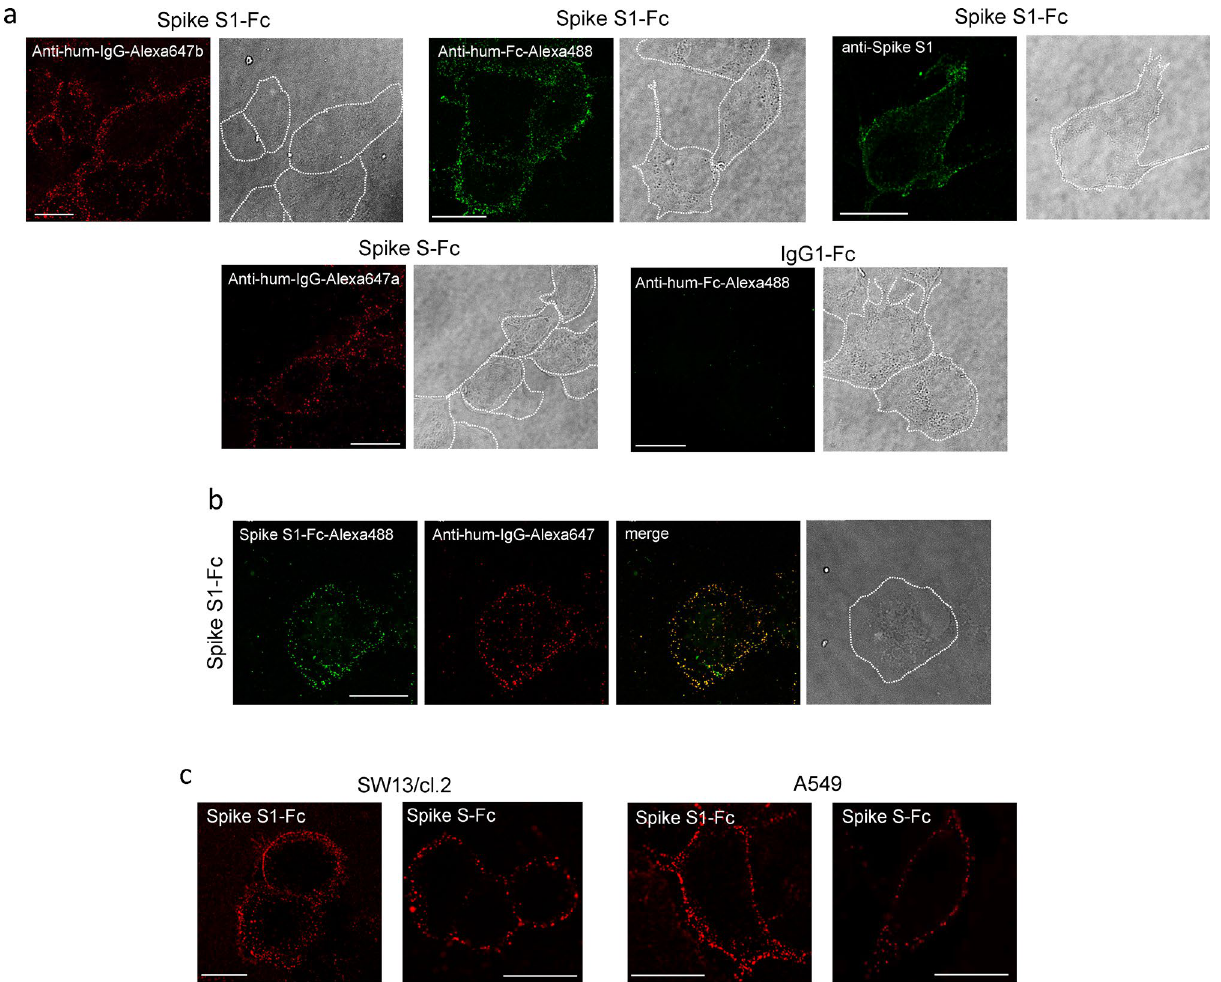
Figure 1. Detection of Spike protein constructs at the cell surface. ( a ) Vero cells plated on glass coverslips were incubated with recombinant Spike S1-Fc, Spike S-Fc, or IgG1-Fc, as indicated, for 1 h in the cold, as described in “Methods”, and the proteins retained on the cell surface were detected with the indicated antibodies. Anti- human (anti-hum) IgG-Alexa647a and Anti-human-IgG-Alexa647b are antibodies raised in goat and alpaca, respectively. ( b ) Cells were incubated with Spike S1-Fc labeled with Alexa488 (green) followed by anti-human IgG-Alexa647 (red) and the overlay of the two signals is shown (merge). In ( a , b ), bright field images in which the approximate cell contours have been highlighted are shown. ( c ) SW13/cl.2 or A549 cells were incubated with Spike S1-Fc or Spike S-Fc, which were detected by incubation with anti-human-IgG-Alexa647. Images shown are single confocal sections taken at mid-height of the cells. Bars, 20